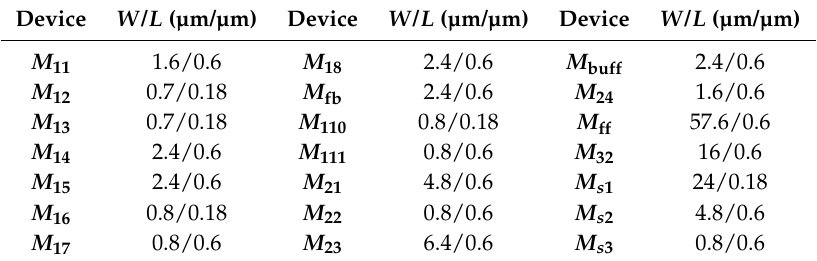
Table 8. Device sizes for the transistors in Figure 12a.